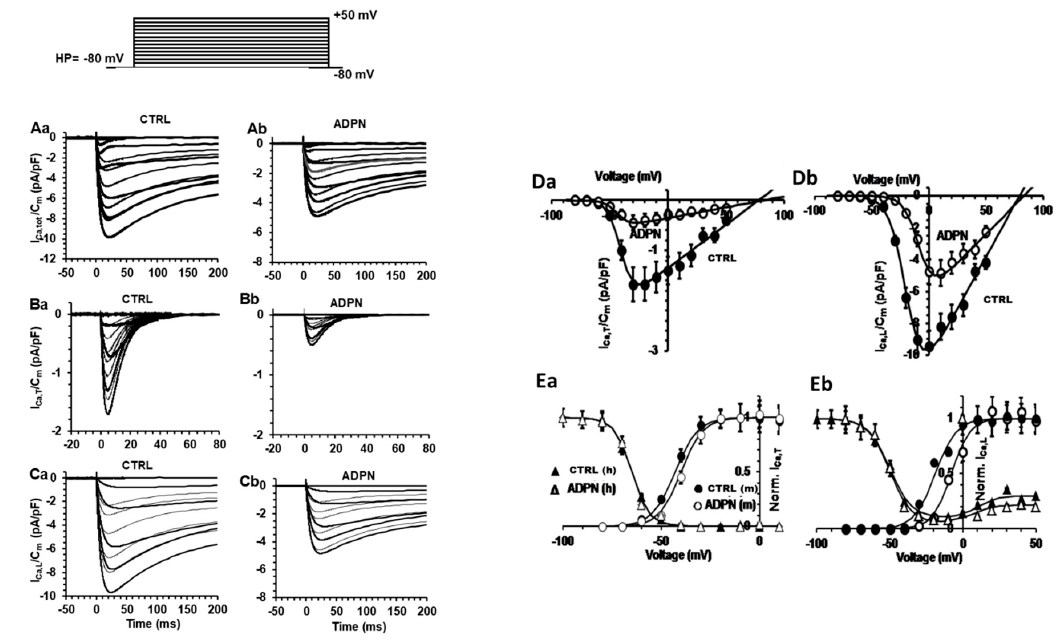
Figure 4. E ff ects of ADPN on the voltage-dependence of T- and L-type Ca 2 + channels activation. ( Aa , Ab ) Current traces of total inward Ca 2 + currents (I Ca ) recorded in control SMC ( Aa ) and in the presence of ADPN ( Ab ). Current values are normalized to cell capacitance. ( Ba , Bb ) Representative time course of T-type Ca 2 + currents (I Ca,T ) recorded in the presence of nifedipine from a control cell ( Ba ) and after ADPN addition ( Bb ). ( Ca , Cb ) Time course showing L-type Ca 2 + currents (I Ca,L ) recorded in the high TEA-Ca 2 + solution from a control cell ( Ca ) and after ADPN addition ( Cb ). Only the first 200 ms of the pulse are depicted. ( Da , Db ) I-V plots related to I Ca,T ( Da ) and I Ca,L ( Db ) in control (CTRL, filled circles) and ADPN-treated (ADPN, open circles) SMCs from the gastric fundus. Data are normalized for the mean cell capacitance. The lines through the experimental data are the fit with a Boltzmann function. ( Ea , Eb ) Steady-state activation and inactivation analysis for I Ca,T ( Ea ) and I Ca,L ( Eb ). E ff ect of ADPN on I CaT and I Ca,L activation (open circles, m) with respect to control (filled circles, m); lack of e ff ects on inactivation (CTRL, filled triangles, h; ADPN, open triangles, h). Note the U-shaped inactivation curve at positive potentials for I Ca,L that is depressed in ADPN-treated cells. Current values are normalized to cell capacitance. All data are mean values ± SEM Statistical significance is not depicted in the figure for clarity but is reported for the various Boltzmann parameters in Table 2. Data are from CTRL n = 20 cells, ADPN n = 7 cells, (5